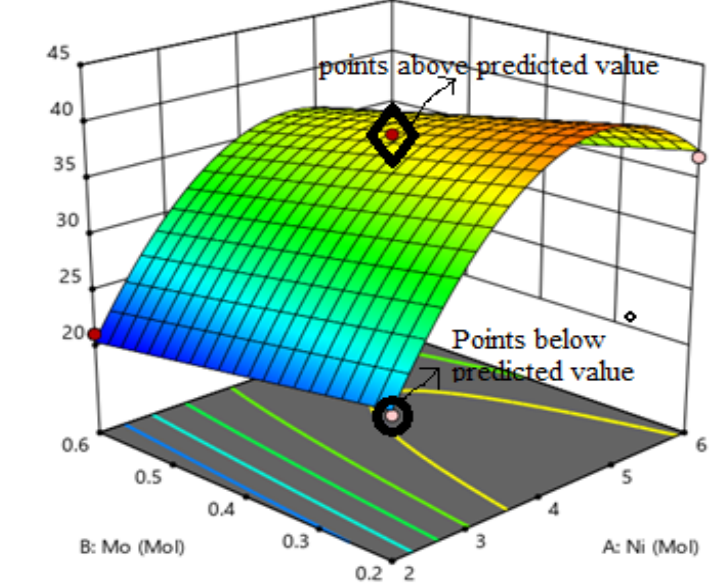
Figure 3. Plot showing catalytic activity of Ni, Mo, and MgO over the carbon yield.